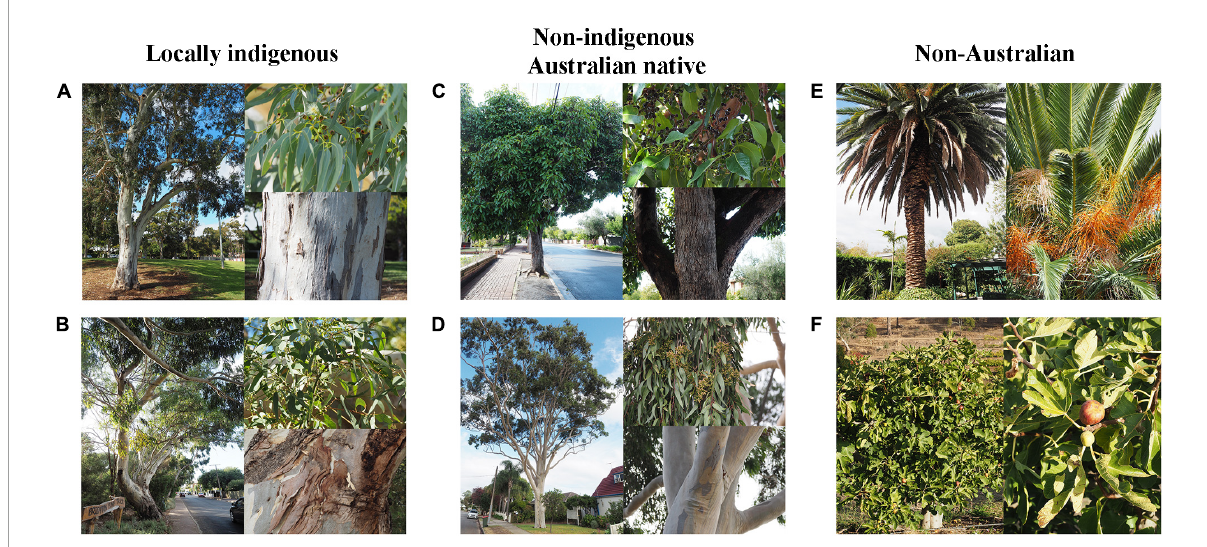
FIGURE2 Example photographs of locally indigenous (to the Adelaide region), non-indigenous Australian native (not originally occurring in South Australia but indigenous to Australia), and non-Australian food plant species visited by nine GPS tracked Pteropus poliocephalus roosting in Adelaide Botanic Park (–34.916, 138.607) between December 2019 and May 2020. (A) Eucalyptus leucoxylon , (B) E. camaldulensis , (C) Lophostemon confertus , (D) Corymbia citriodora , (E) Phoenix canariensis , and (F) Ficus carica.